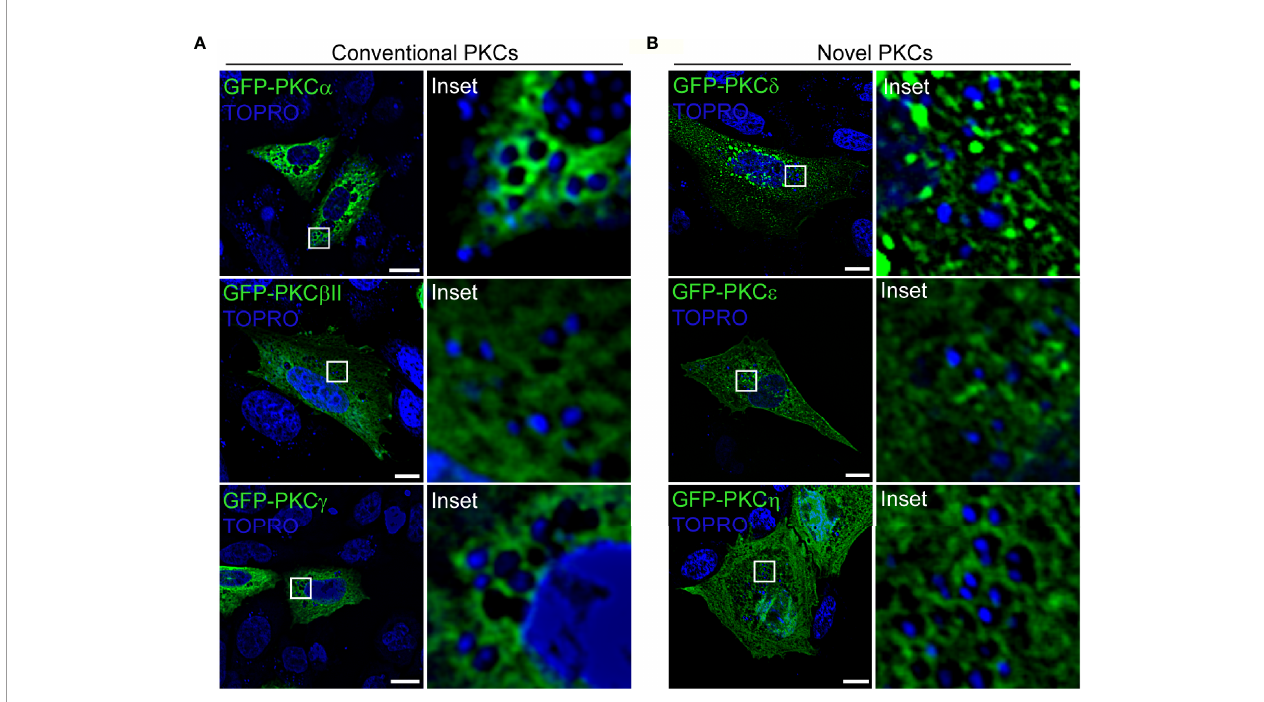
FIGURE 2 | PKC a is recruited to S. aureus phagosomes. (A) Confocal microscopy images of CHO cells overexpressing each of the three members of the conventional PKCs family: GFP-PKC a , GFP-PKC b II, GFP-PKC g . Cells were infected with S. aureus wt for 4 hours. Bacteria were labelled with Topro (shown in blue). Bar: 10 m m. (B) Confocal microscopy images of CHO cells transfected with members of the novel PKC family: GFP-PKC d , GFP-PKC ϵ or GFP-PKC h . Cells were infected with S. aureus wt for 4 hours. Bacteria were labelled with Topro (shown in blue). Bar: 10 m m. Figures are representative of fi ve independent